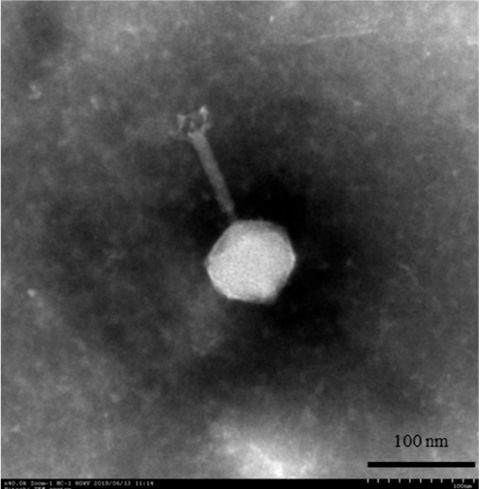
Figure 1. Morphology of phage PN09 observed using transmission electron microscopy.